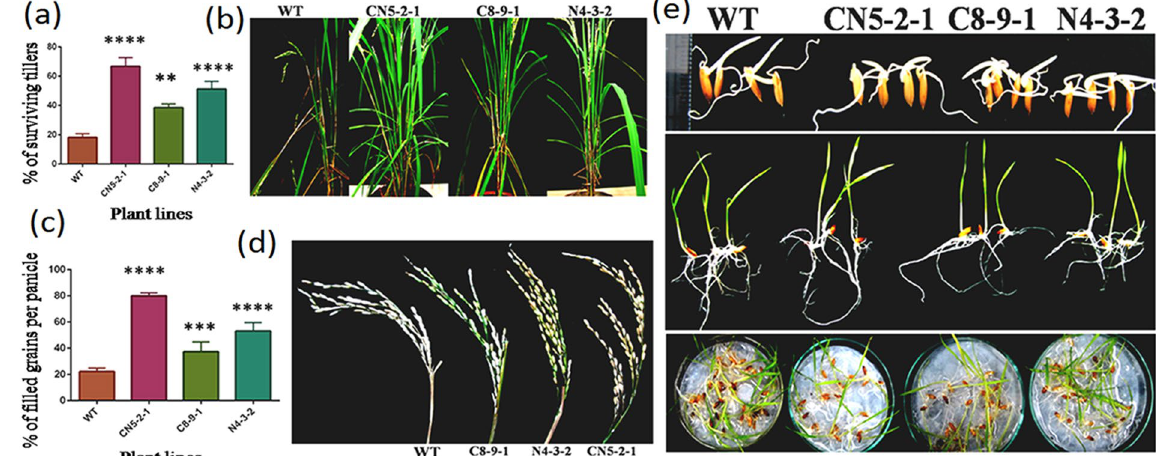
Figure 7. Enhanced resistance of transgenic lines to highly virulent isolates of R . solani and seed germination analysis. ( a ) Bar diagram showing percentage of survival tillers in T 2 transgenic lines (CN5-2-1, C8-9-1, and N4-3-2) compared to wild type (WT) after 21 dpi. Bar represents mean ± SE of three independent experiments. ( b ) Images showing more number of surviving tillers in T 2 transgenic lines (CN5-2-1, C8-9-1, and C4-3-2) compared to WT after 21 dpi. ( c ) Percentage of filled grains per panicle on transgenic and non-transformed control after 21 dpi. Bar represents mean ± SE of five independent experiments. ( d ) Images showing more grain count per panicle in transgenic plants after sheath blight infection with respect to WT at 21 dpi. ( e ) Images showing seed germination and phenotypic evaluation of T 3 transgenic and wild type (WT) control seeds at juvenile stage.